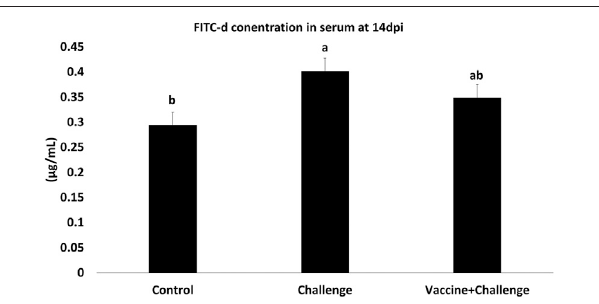
FIGURE3| FITC-dconcentrationintheserumofvaccinatedbirds.Atd1 of age birds were allocated into treatment groups: 1) Control; 2) Challenge; or 3) Vaccine + Challenge. At d1 and d7 of age birds in the negative and positive control groups were mock vaccinated with PBS and birds in the treatmentgroupwerevaccinatedwithCNP.Atd14ofagebirdsinthenegative controlgroupweregivenamockchallengeof0.5 mlPBS/birdandbirdsinthe positive control and the treatment group were orally challenged with 1 × 10 7 CFU/bird of S . Enteritidis. At 14 dpi, one bird per pen was given 2.2 mg FITC-d by oral gavage. After 2 h blood samples were collected. The Optical Density (OD) was measured at 485 nm. Bars (+SE) with no common superscript differ ( p <